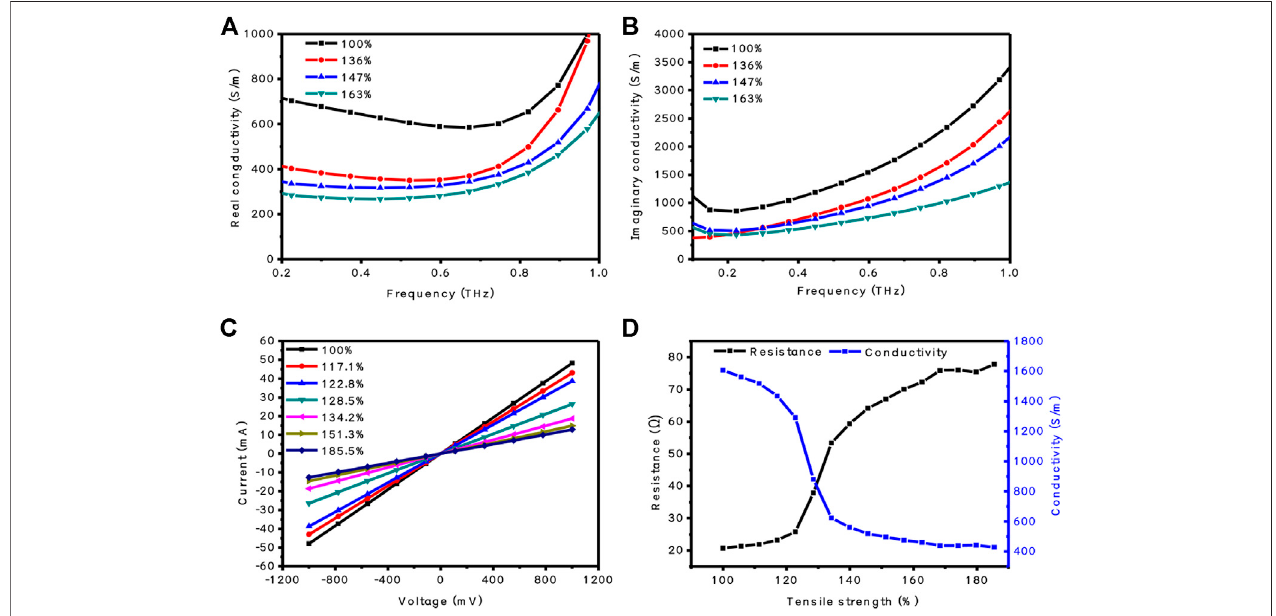
FIGURE 5 | (A) Change in the real part of the conductivity of samples at different tensile degrees. (B) Change in the imaginary part of the conductivity of samples excited by different tensile degrees. (C) I-V diagram for electrical characterization of samples at different tensile degrees. (D) Relationship between the resistance and conductivity of the sample with respect to the tensile degree during electrical